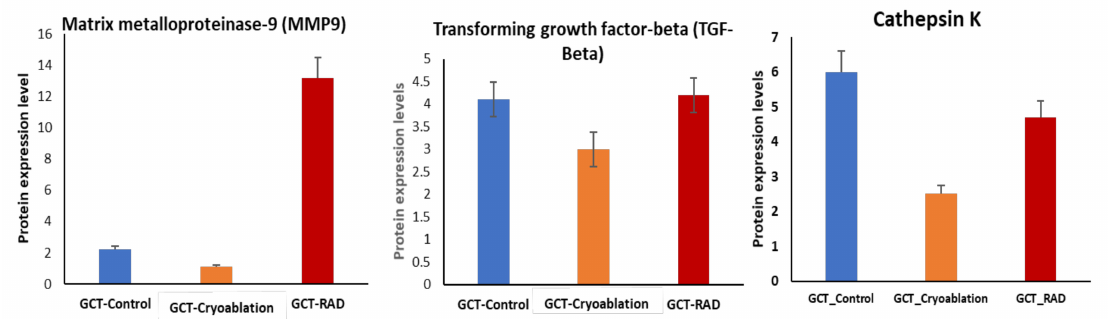
Figure 3. Di ff erences in protein abundance of MMP9, TGF-Beta, Cathepsin K between GCT-untreated / GCT-Control (in blue), GCT-cryoablation treated (orange) and GCT-irradiation treated / GCT-RAD (in red). The higher expressions in GCT-untreated / control was showed reduced expressions after cryoablation treatment were under positive selection if they exhibited p < 0.01 and FDR > 0.01. p values represented in the figure corresponds to the two-tailed Student’s t -test. Error bars denote mean ±